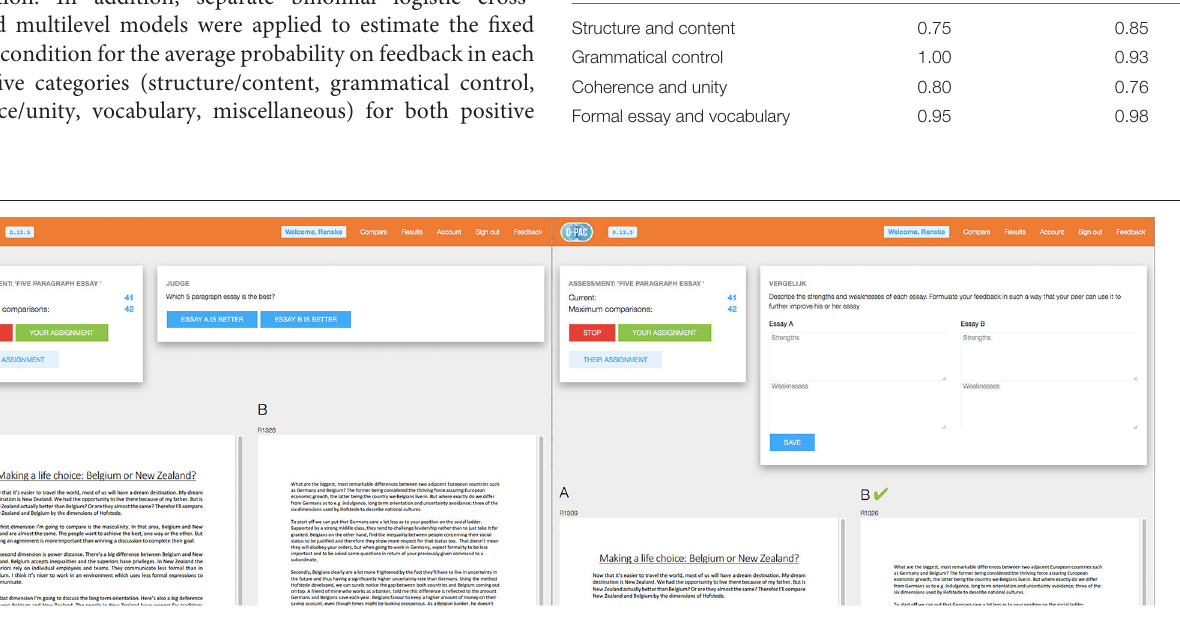
FIGURE 1 | A screen capture of the online platform D-PAC. The left pane (1A) shows how a pair of essays is presented on the screen and how students can make their comparative judgment. After a judgment is made, it is automatically followed by the screen presented in the right pane (1B) , in which students can optionally provide feedback on strengths and weaknesses per